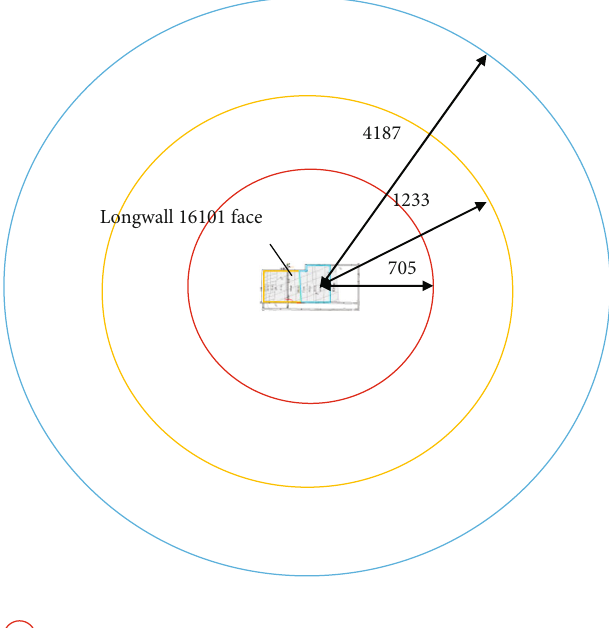
Figure 8: Prediction of ground vibration damage boundary of the mine quake in the longwall 16101 face (unit: